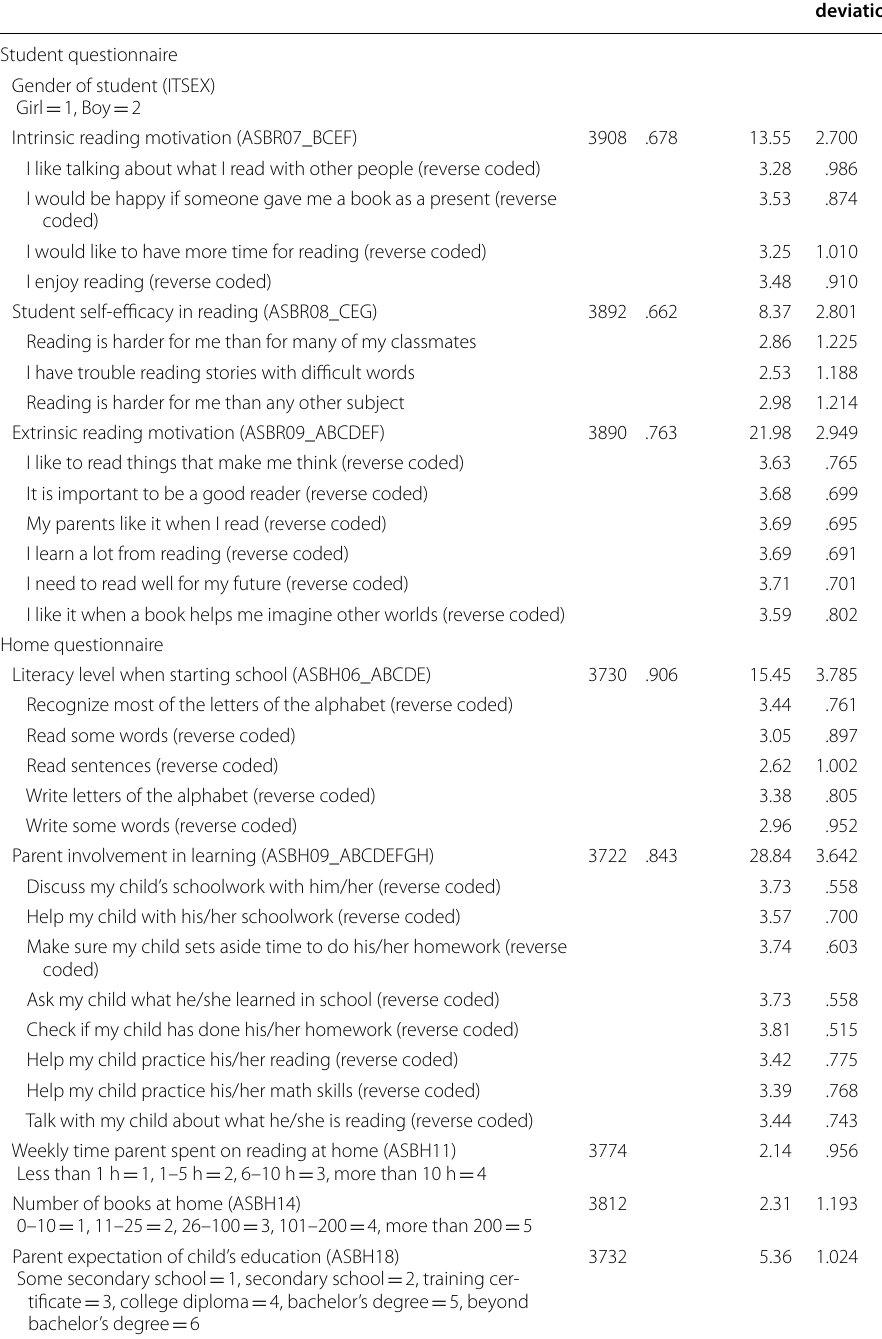
Table 2 Summary of questionnaire